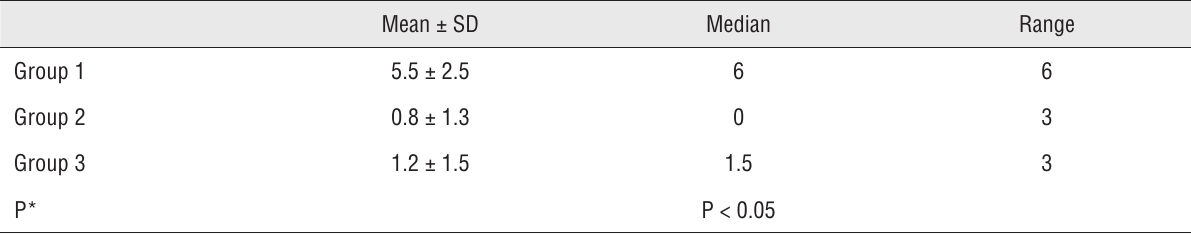
Table 1 - Comparison of the three